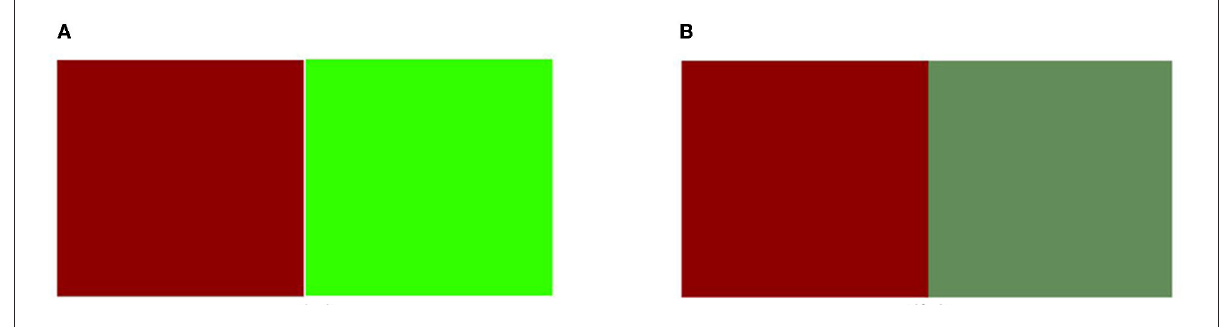
FIGURE5 (A) Contrasting color pairs of the same chroma. (B) Contrasting color pairs of the same